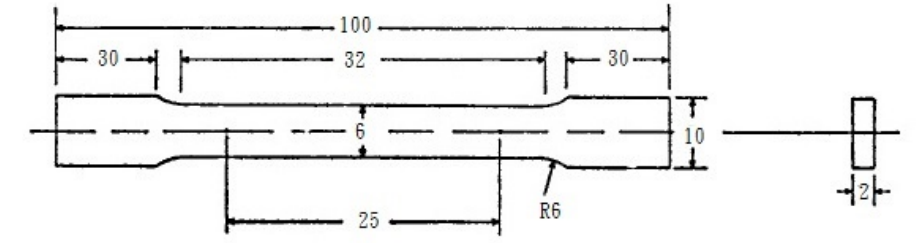
Figure 9. The dimensions of the tensile test piece (unit: mm) [22].